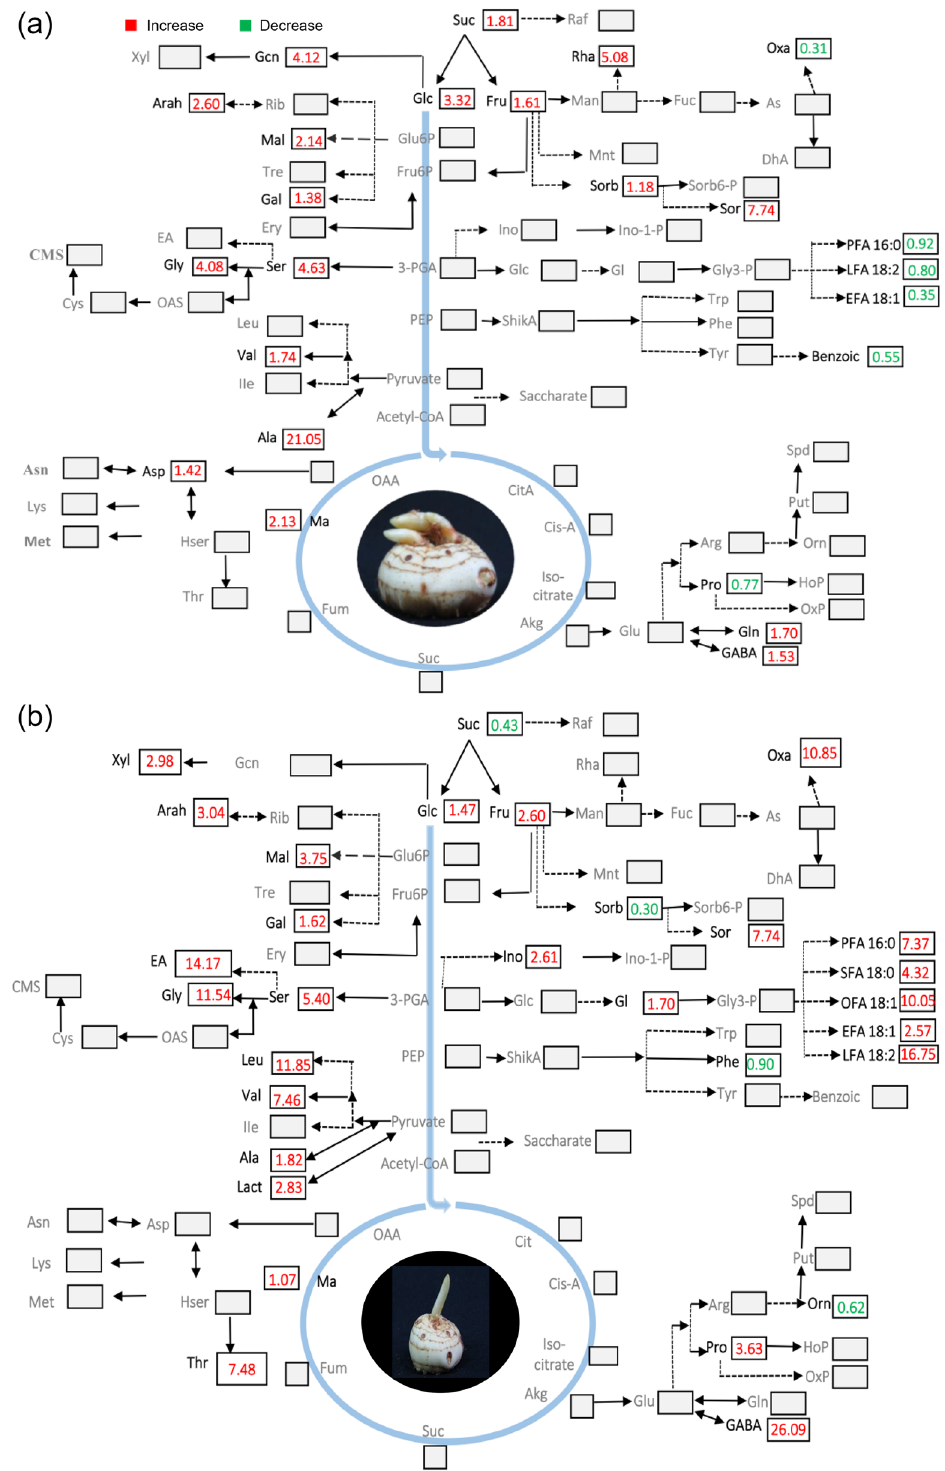
Figure 5. Metabolic map depicting fold change (P < 0.05) in metabolites between S2 and S1 ( a ) and S3 and S2 ( b ) developmental stages of Crocus corm. Undetected metabolites are denoted by grey characters. The metabolites identified in this study are: Alanine (Ala); Aspartate (Asp); Arabino-hexose (Arah); Elaidic acid (EFA18:1); Ethanolamine (EA); Fructose (Fru); Galactose (Gal); Gamma-aminobutyric acid (GABA); Glucose (Glc); Glutamine (Gln); Glycine (Gly); Glyceric (Glc); Gluconic acid (Gcn); Lactic acid (Lact); Leucine (Leu); Linoleic acid (LFA18:2); Myo-inositol (Ino); Maltose (Mal); Malic acid (Ma); Oleic acid (OFA18:1); Ornithine (Orn); Oxalic acid (Oxa); Palmitic acid (PFA16:0); Phenylalanine (Phe); Proline (Pro); Ribose (Rib); Serine (Ser); D-Sorbitol (Sorb); Sorbose (Sor); Stearic acid (SFA18:0) Sucrose (Suc); Threonine (Thr); Valine (Val); Xylose